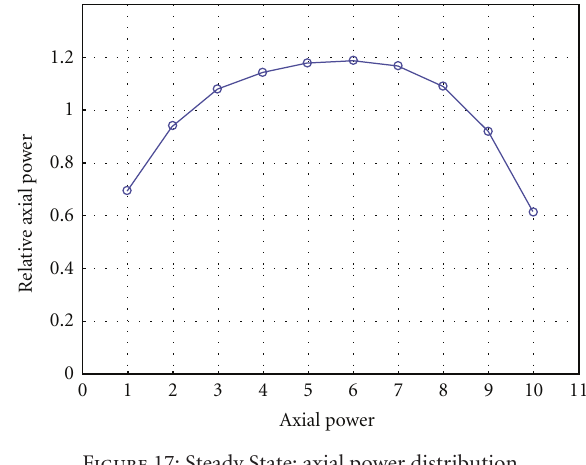
Figure 17: Steady State: axial power distribution.